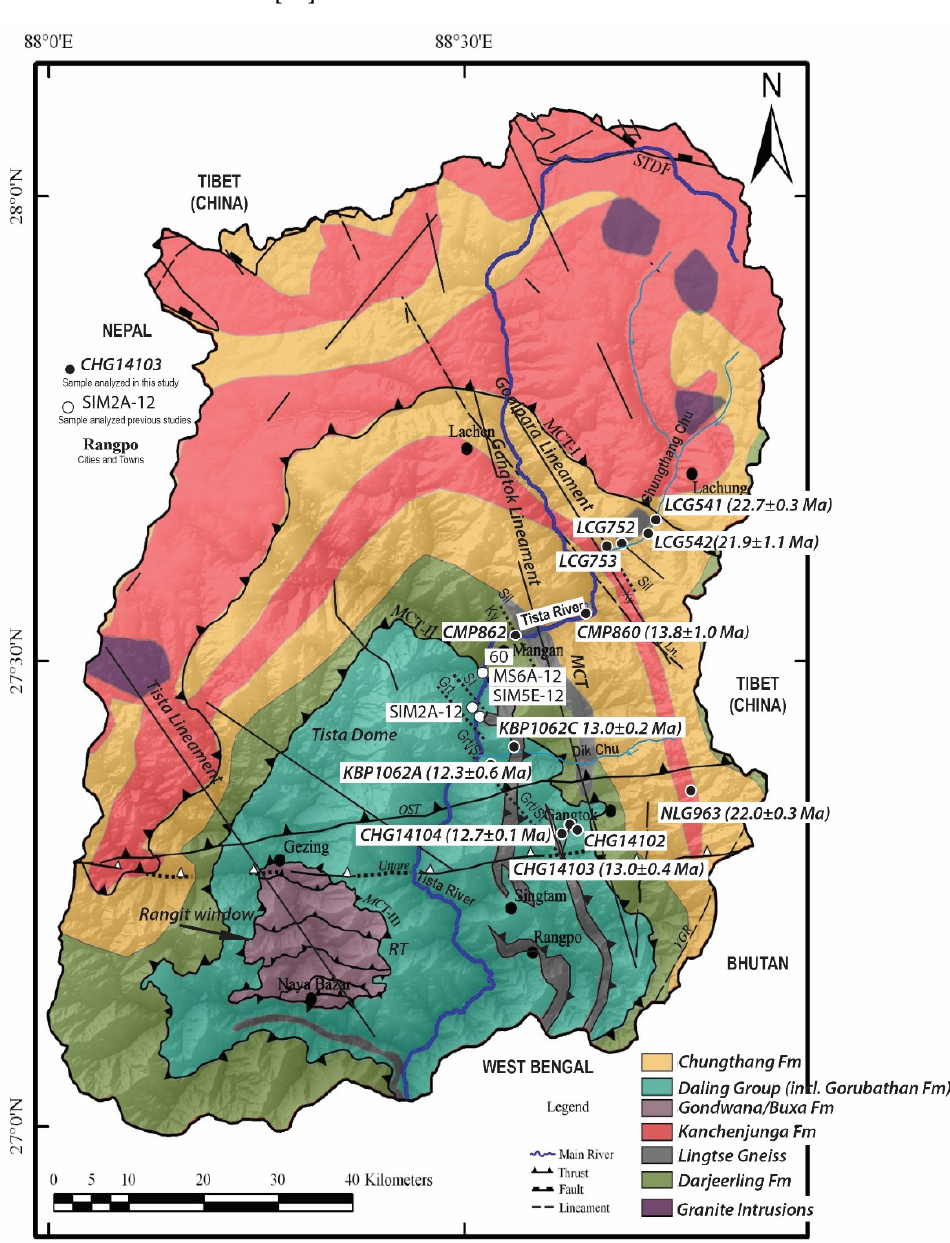
Figure 1. Geological Map of the Sikkim Himalayas. Samples and average monazite ages indicated after [5,6]. We note that the specific locations of major fault system are inconsistently mapped and named and refer the reader to maps of additional structures possibly present as outlined in [9,14,26], among others. Specific formations that our samples belong found are based on mapping by [26] and are listed in Table 1. We include the locations of samples collected by others discussed in the text [27,28]. RT = Ramgarh thrust; OST= out of sequence thrust; YGR = Yadong-Gulu rift; STDF = South Tibet Detachment Fault. We include the map by [26] with our sample locations in the data reposi- tory.